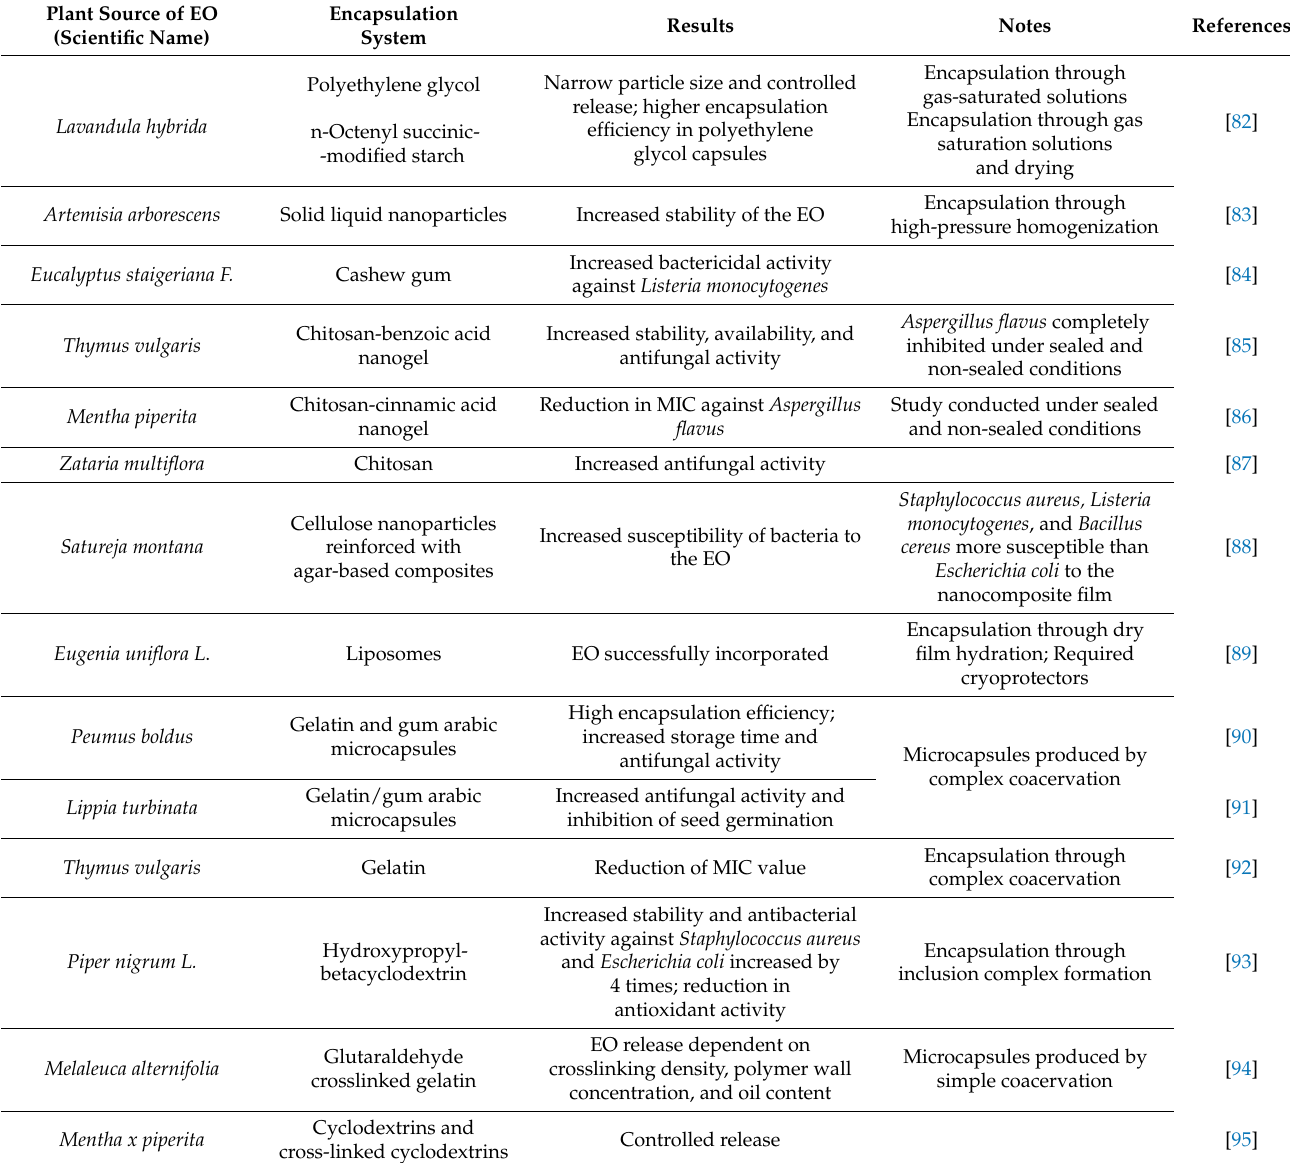
Table 4. EODS encapsulation